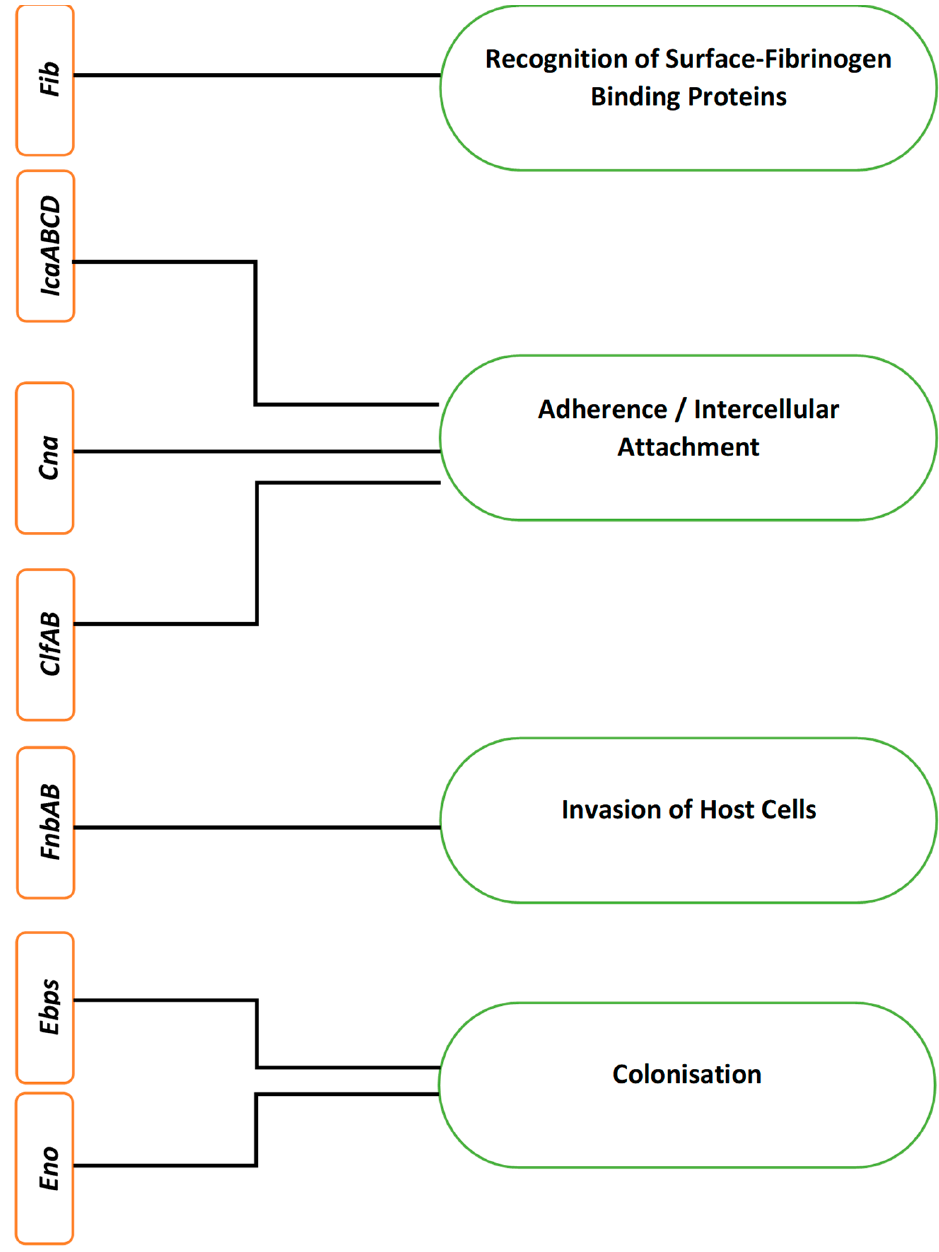
Figure 2. Different genes and their corresponding encoding in Staphylococcus aureus biofilm formation. Clumping factor genes clfA and clfB encode cell wall-anchored proteins that attach to the surface fibrinogen of the host [36]. This attachment of clumping factors A and B encoded by clfAB genes facilitates S. aureus colonisation of the host, promotes biofilm formation and causes virulence by means of immune evasion through binding soluble fibrinogen [13,37]. Serine-aspartate repeat factors C and D (SdrCD) facilitate attachment to desquamated epithelial cells and nasal colonisation, while SdrE causes immune evasion by binding to complement factor H [13]. These proteins are encoded for their respective roles by the corresponding s dr genes [38]. The encoding of elastin-binding proteins and laminin- binding proteins by their respective genes, ebps and eno genes, facilitates colonisation of the host and biofilm formation